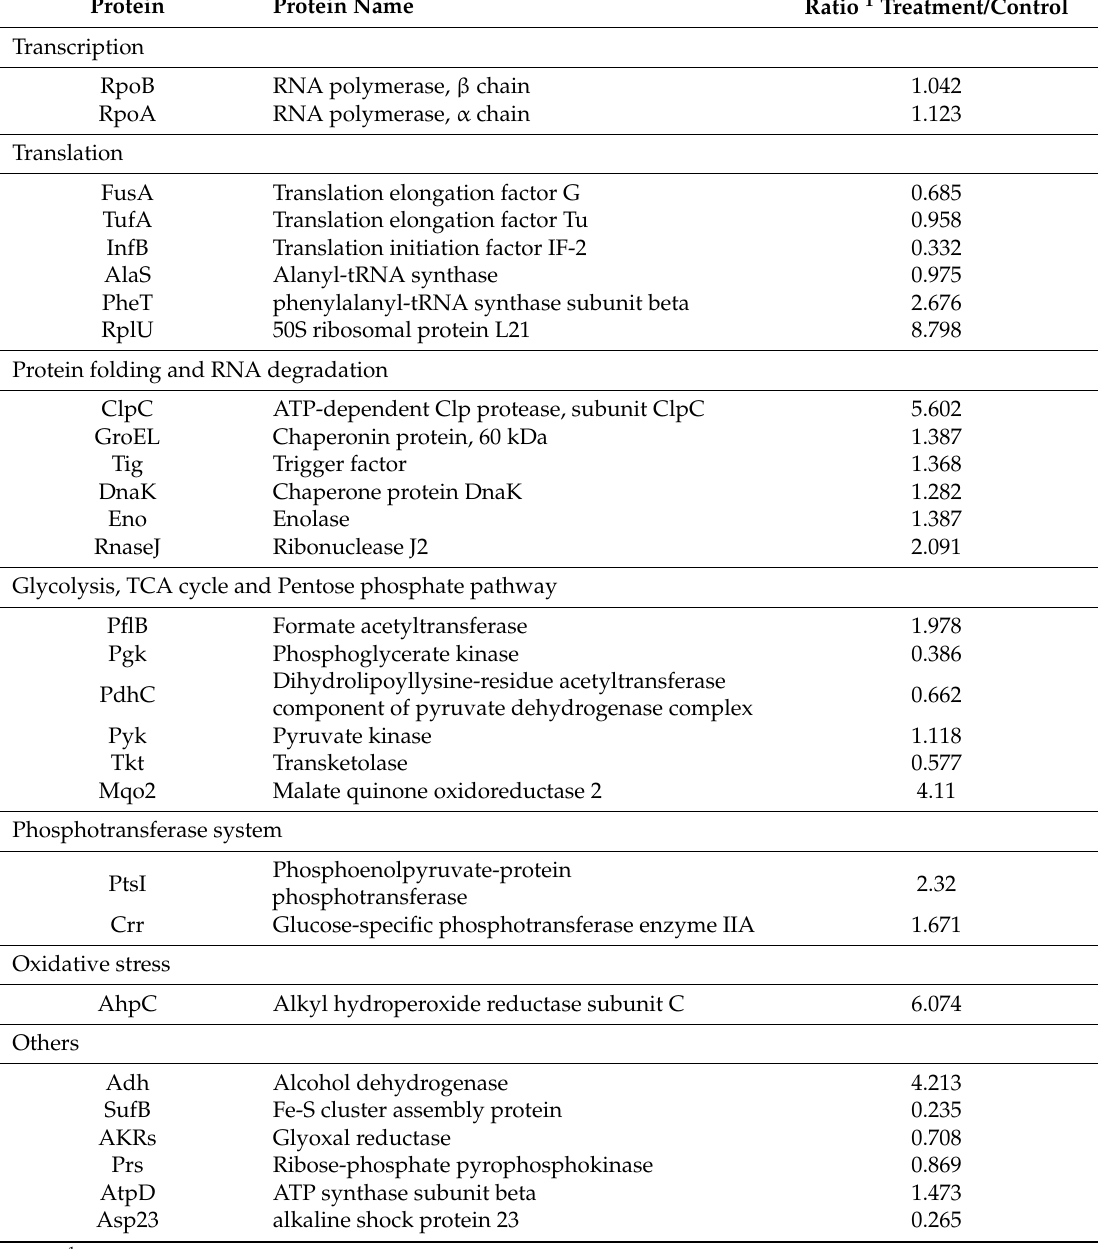
Table 3. Changes in protein expression in MRSA following treatment with ursolic